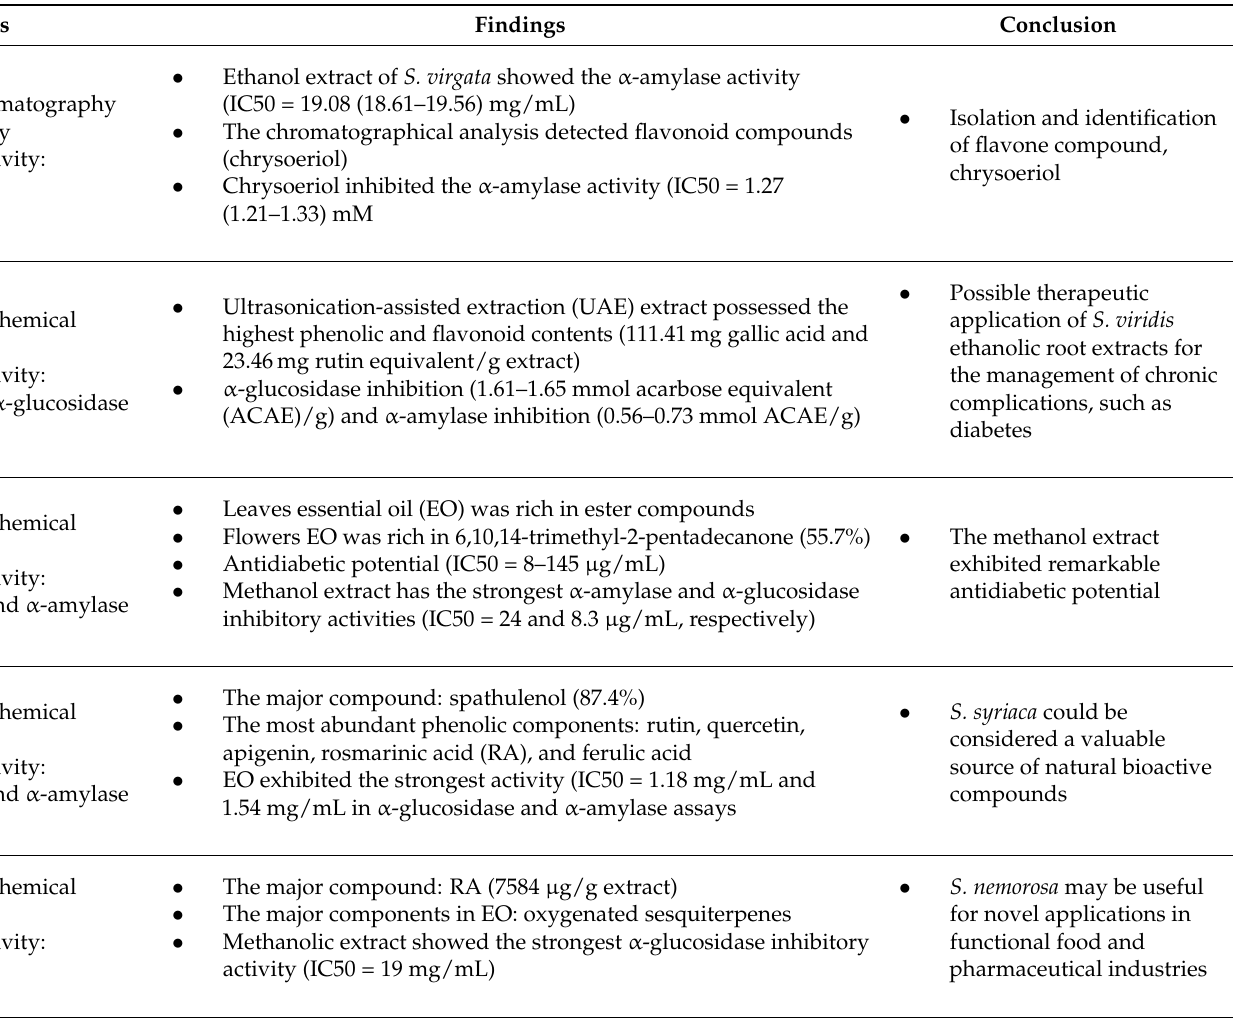
Table 1. Bioactive components of Salvia spp. and their antidiabetic